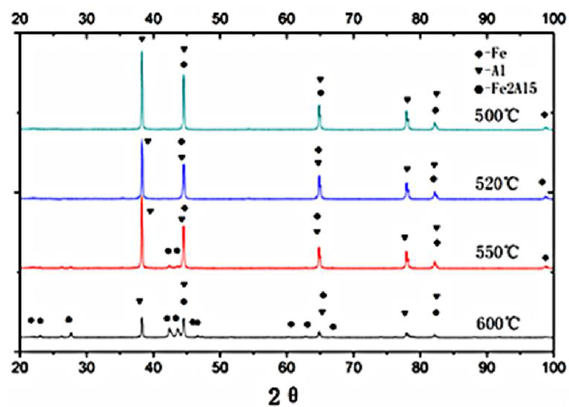
Figure 6. XRD patterns of the Fe/Al composites with different maximum sintering temperatures.